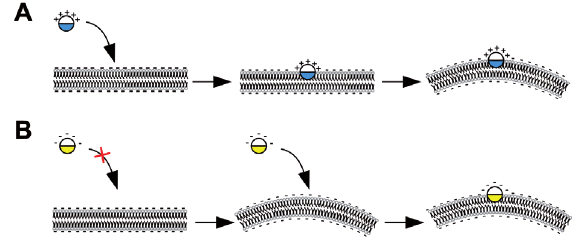
Figure 4 Amphipathic helices as membrane curvature sensors or